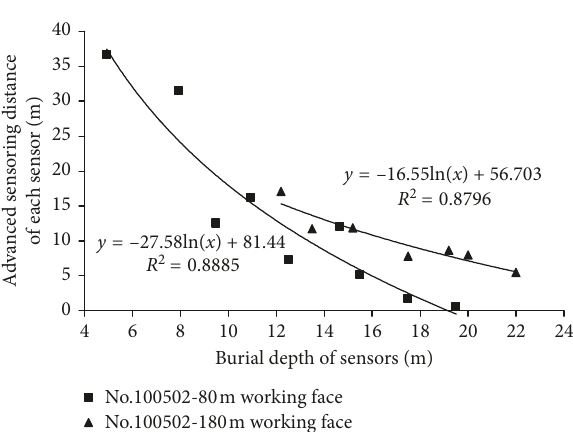
Figure 8: Relationship between the buried depths of the sensors and their lagged response